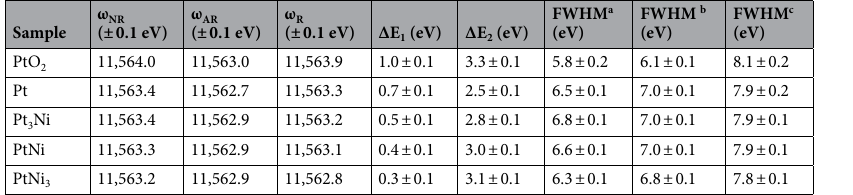
Table 1. Summary of emission energies ω NR , ω AR , ω R , energy difference ΔE 1 , energy transfer ΔE 2 , and FWHM of the samples. The detailed analyses are shown in the SI. The step size of the raster scan is 0.5 eV (for both the excitation and emission energies). The error analyses are based on the smoothed spectra, with uncertainty of ~ 0.1 eV in emission energy. a Excitation energies are below resonance, at 11,560.8–11,562.8 eV. Averaged values are displayed. b Excitation energies are at resonance. c Excitation energies are above resonance, at 11,578.5 ~ 11,580.5 eV. Averaged values are